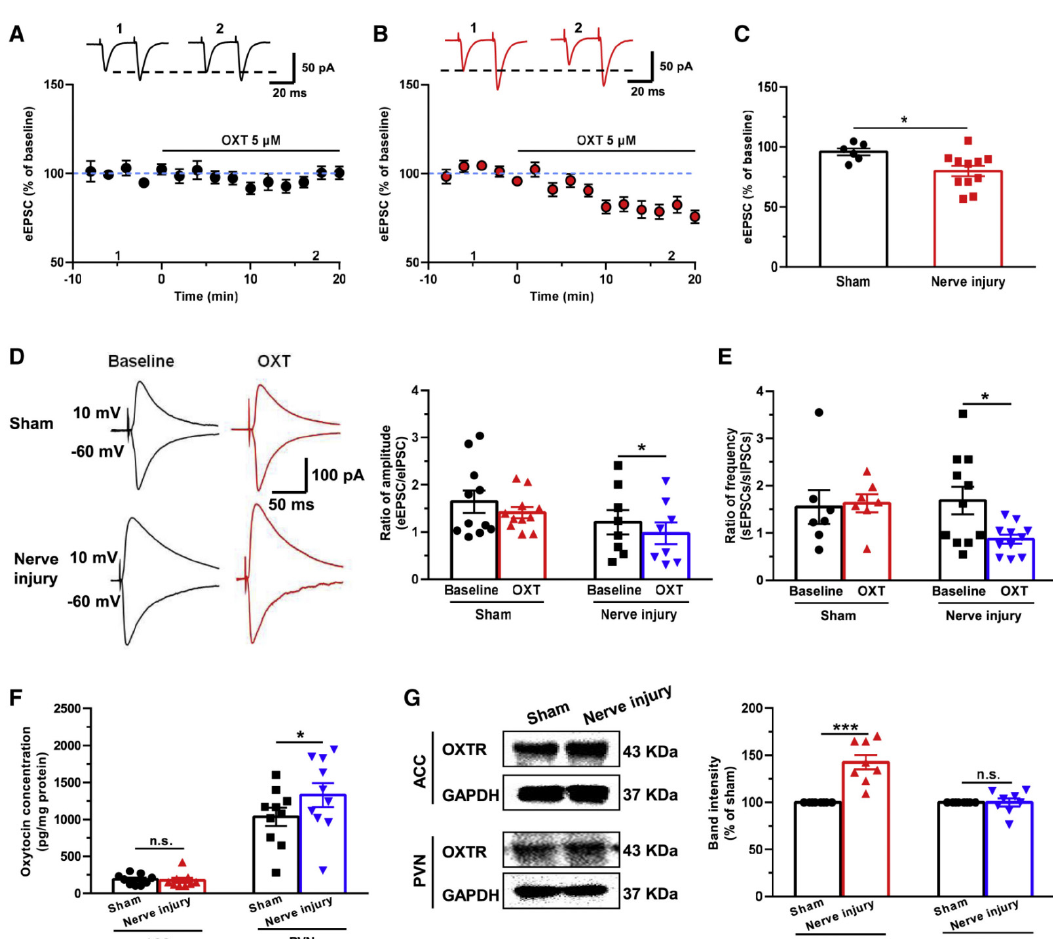
Figure 4. Oxytocin enhances the inhibitory transmission in the ACC after nerve injury. ( A ) Oxytocin did not alter the amplitudes of eEPSCs in the ACC neurons of sham mice (n = 6 neurons/5 mice). ( B ) Oxytocin reduced the amplitudes of eEPSCs in the ACC neurons of nerve-injured mice (n = 11 neurons/5 mice). Representative traces of pair-pulse eEPSCs at baseline (1) and after application of oxytocin (2). ( C ) Summary of the effects of oxytocin on amplitudes of eEPSCs in the ACC neurons of sham and nerve-injured mice. The amplitudes of eEPSCs were statistically different between the sham and nerve injury neurons (* p < 0.05, unpaired two-tailed t -test). ( D ) Representative traces of evoked excitatory and inhibitory responses were recorded before and after the application of oxytocin in the ACC of sham and nerve-injured mice. The evoked E-I ratio was reduced by application of oxytocin in the nerve-injured mice (n = 8 neurons/6 mice), while unchanged in the sham group (n = 11 neurons/5 mice). Two-way ANOVA, F (1,34) = 4.26, p = 0.046. * p < 0.05. ( E ) Summary of the effects of oxytocin on the frequency E-I ratio of sEPSCs/sIPSCs in the sham and nerve-injured mice. The frequency E-I ratio of sEPSCs/sIPSCs was reduced by oxytocin in the nerve-injured mice (n = 11 neurons/6 mice), while not changed in the sham group (n = 7 neurons/5 mice). Two-way ANOVA, F(1,32) = 4.67, p = 0.032. * p < 0.05. ( F ) The oxytocin concentration was tested by ELISA kit in the ACC and PVN after nerve injury (ACC: n = 9 mice/group, p > 0.05; PVN: n = 10 mice/group, * p < 0.05; unpaired two-tailed t -test). n.s. means non-significant. ( G ) Representative Western blots and summary results of oxytocin receptors (OXTRs) expression in total proteins of the ACC and PVN in sham and nerve-injured mice. The oxytocin receptor expression was significantly increased in the ACC after nerve injury compared with the sham group, while not changed in the PVN (ACC: n = 8 mice/group, *** p < 0.001; PVN: n = 8 mice/group, p > 0.05; unpaired two-tailed t -test). n.s. means non-significant. All error bars denote standard errors. Reprinted with permission from Ref. [126]. 2021, Xu-Hui